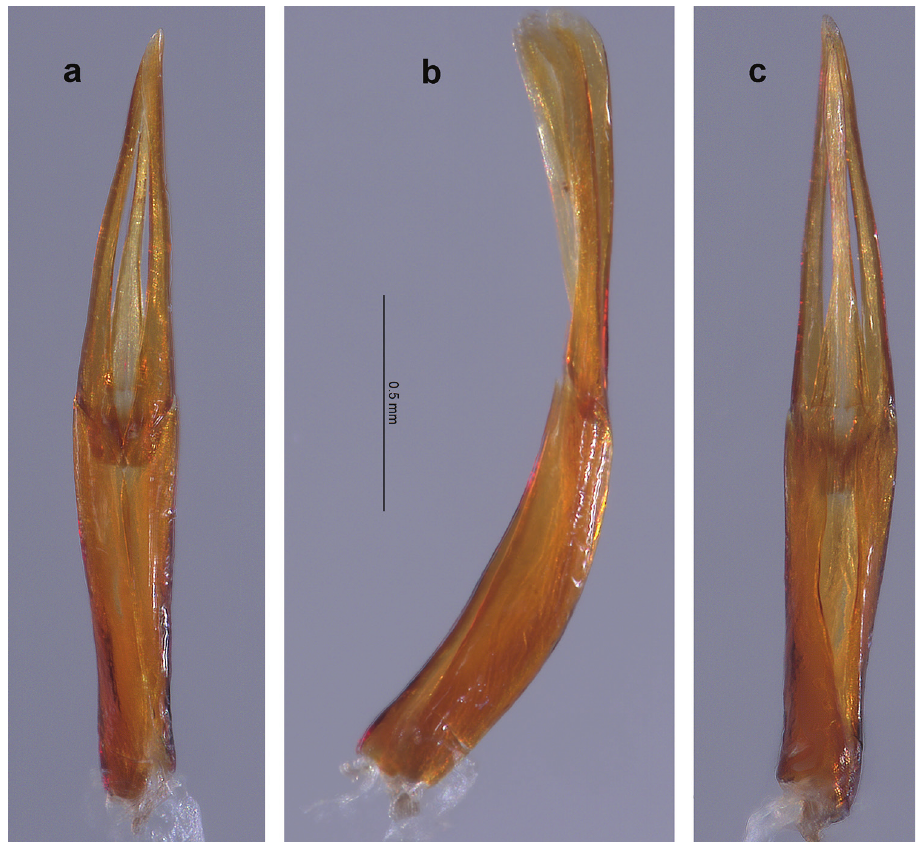
Figure 5. Amazonopsis theranyi sp. n. , male genitalia of paratype from Venezuela a Dorsal view b Lateral view c Ventral